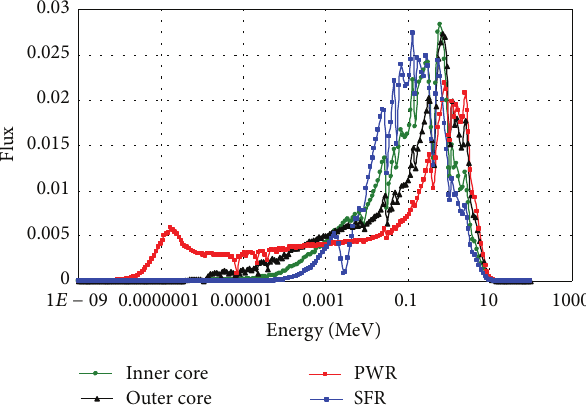
Figure 5: Spectrum comparison of SCFR (inner and outer core), PWR, and